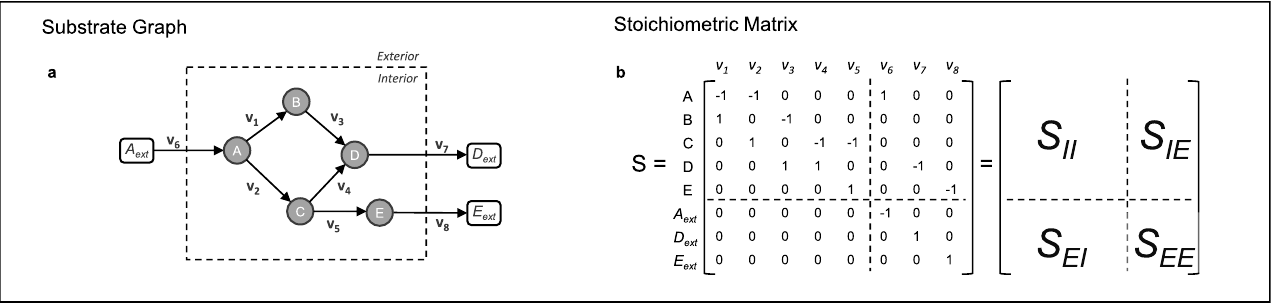
Figure 2. Partitioning of the stoichiometric matrix of the running example. ( a ) The substrate graph representation of the running example metabolic network. ( b ) The corresponding stoichiometric matrix divided in the four characteristic sub-matrices. S II : Intracellular metabolites reaction coefficients w.r.t intracellular reactions. S IE : Intracellular metabolites reaction coefficients w.r.t exchange reactions. S EI : Extracellular metabolites reaction coefficients w.r.t intracellular reactions, always zero. S EE : Extracellular metabolites reaction coefficients w.r.t exchange reactions, always